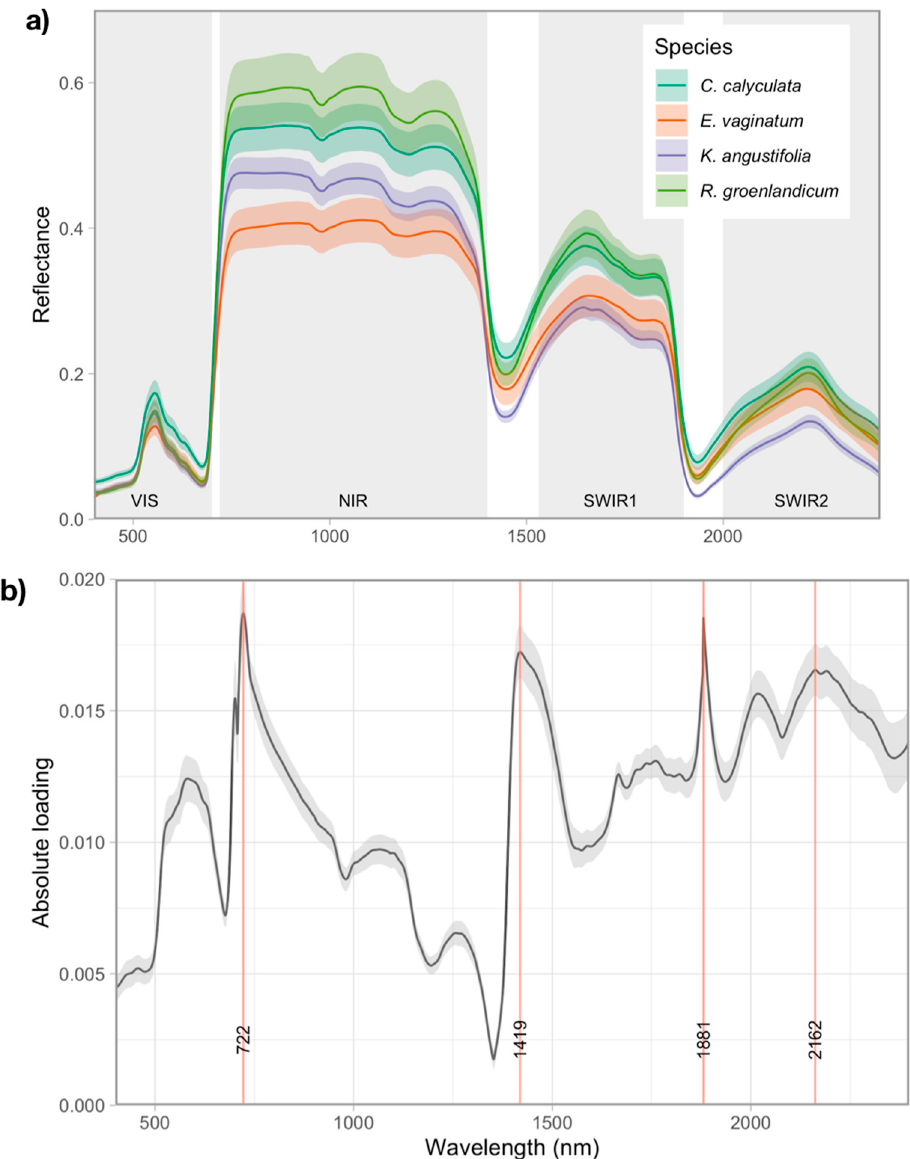
Figure 6. ( a ) Mean ( ± standard deviation) of absolute reflectance spectra per species and spectral regions (VIS: visible, NIR: near-infrared, and SWIR: short-wave infrared). ( b ) Absolute wavelength loadings revealing their contribution to species discrimination through PLSDA analysis.